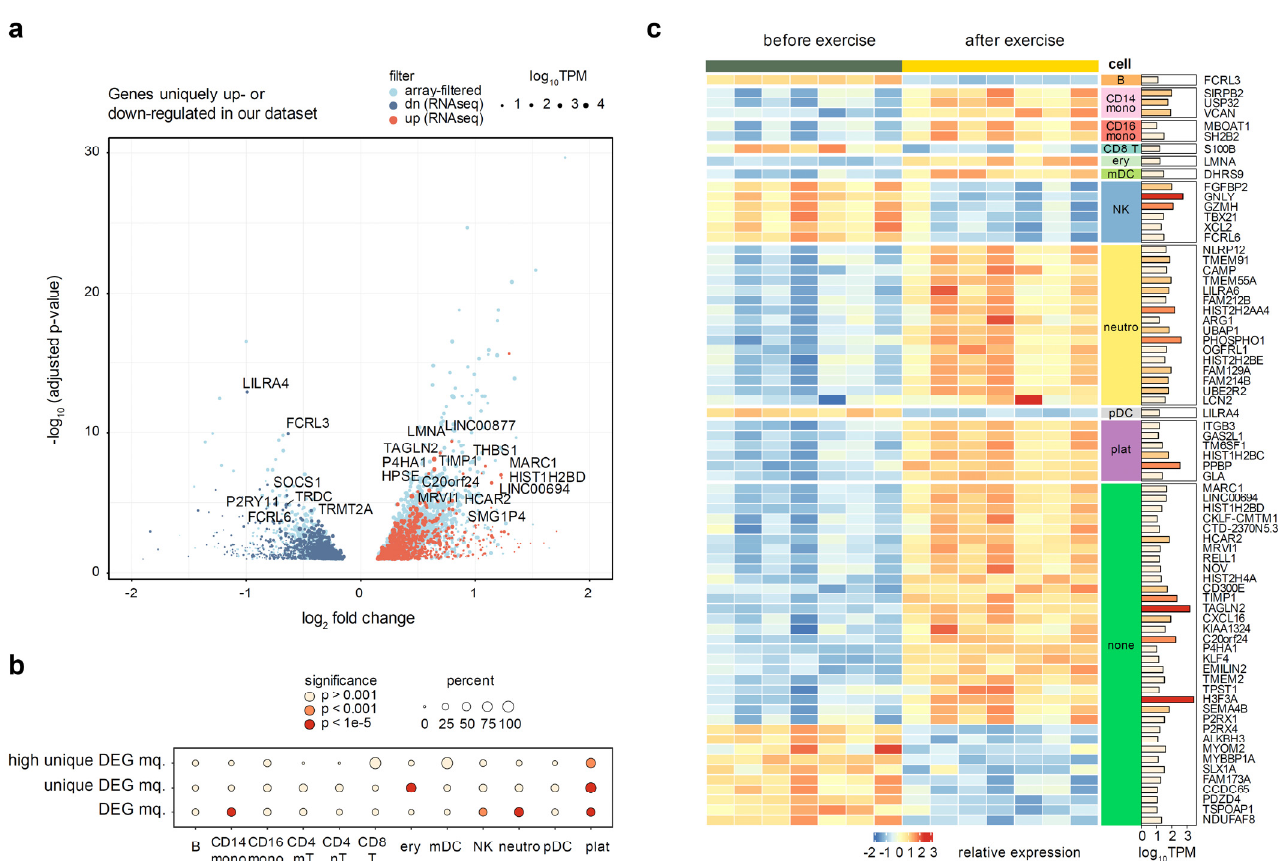
Figure 4. Analysis of genes uniquely up- or down-regulated in our dataset, as compared to seven public microarray datasets. Full list of datasets is given in Supplementary Table S1. ( a ) Volcano plot of genes uniquely regulated in the whole blood of altitude-adapted skaters. Light blue points indicate differentially expressed genes previously seen in at least one other exercise dataset. Point size is scaled proportionally to mean gene expression. ( b ) A circle plot representing the enrichment of cell type markers among all differentially expressed genes and altitude-specific differentially expressed genes. The size of the circle is proportional to the percentage of marker genes in the target set, and the fill of the circle corresponds to the significance levels of Fisher’s exact test. ( c ) Heatmap of highly expressed (TPM > 10) and regulated (absolute log fold change > 0.5) genes unique to our dataset. Breakdown by cell type is conducted based on single cell markers defined earlier. Rows are sorted by cell type and then by log fold change.